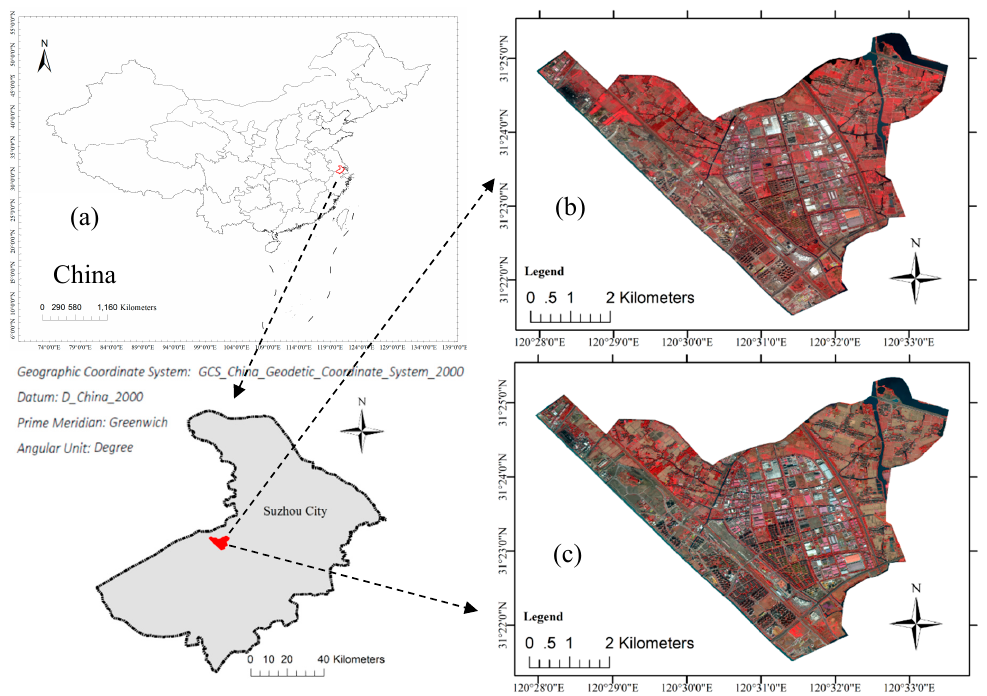
Figure 1. The experimental GF-2 remote sensing imageries in the selected study area: ( a ) the location of study area ( b ) previous reference image; ( c ) current target image.